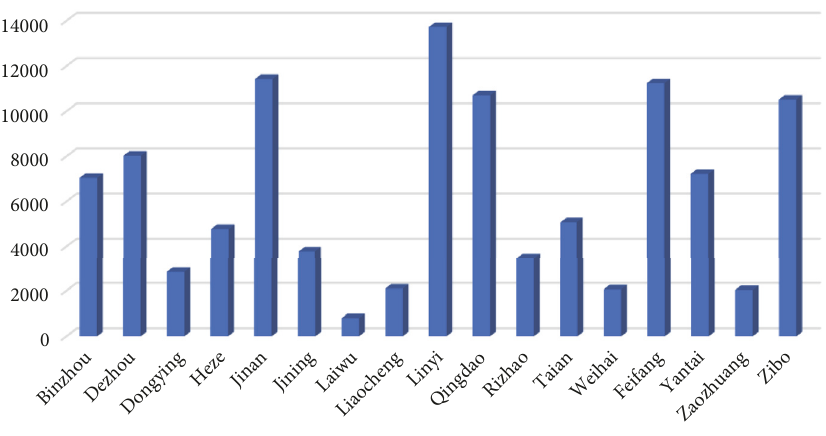
Figure 1: The accident data for each city in three